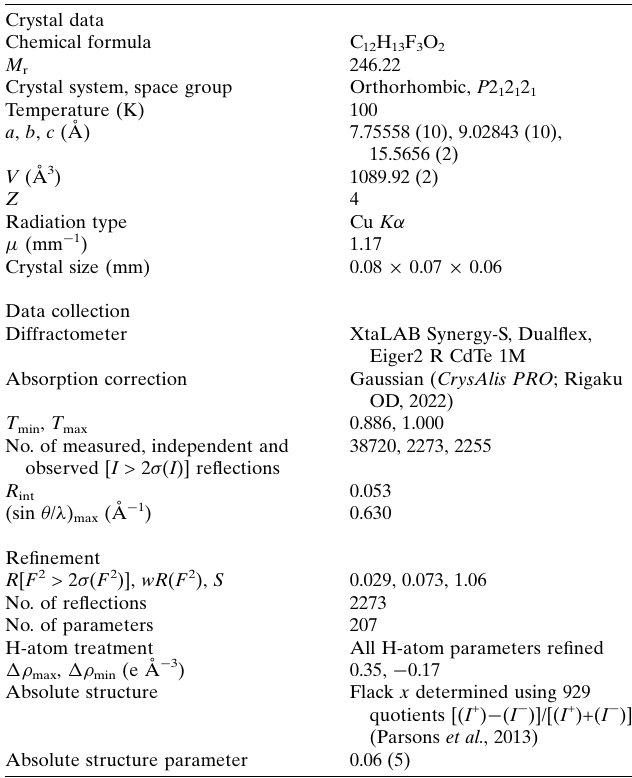
Table 1 Hydrogen-bond geometry (A˚ , (cid:4) ).